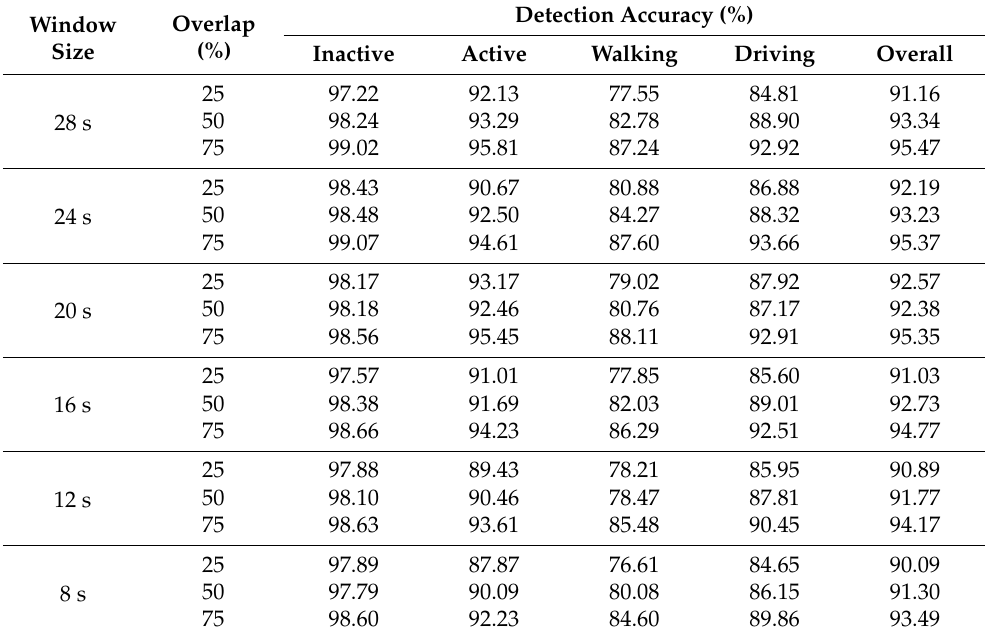
Table 1. Detection accuracy with varying overlap values.